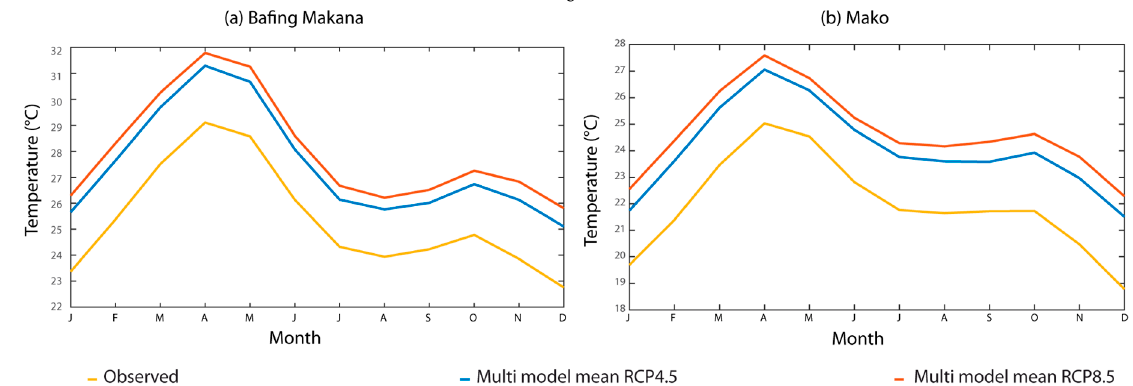
Figure A2. Projected temperature at Bafing Makana ( a ) and Mako ( b ) under RCP4.5 and RCP8.5. Table A1. Relative change in characteristic high flow for different used GCM under RCP4.5.